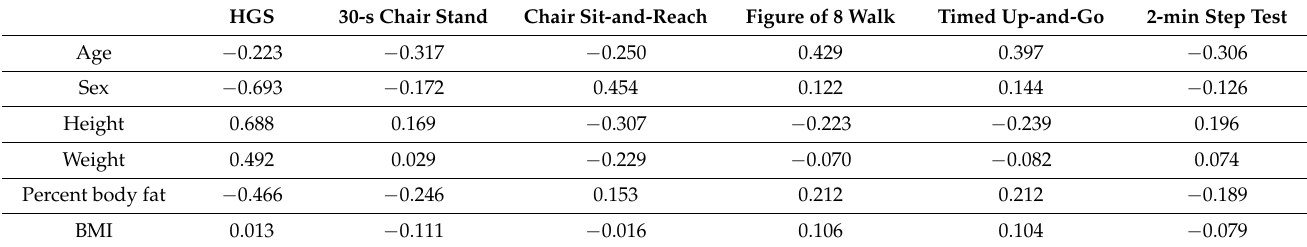
Table 2. Pearson’s correlation analysis between the independent variables and FF variables.